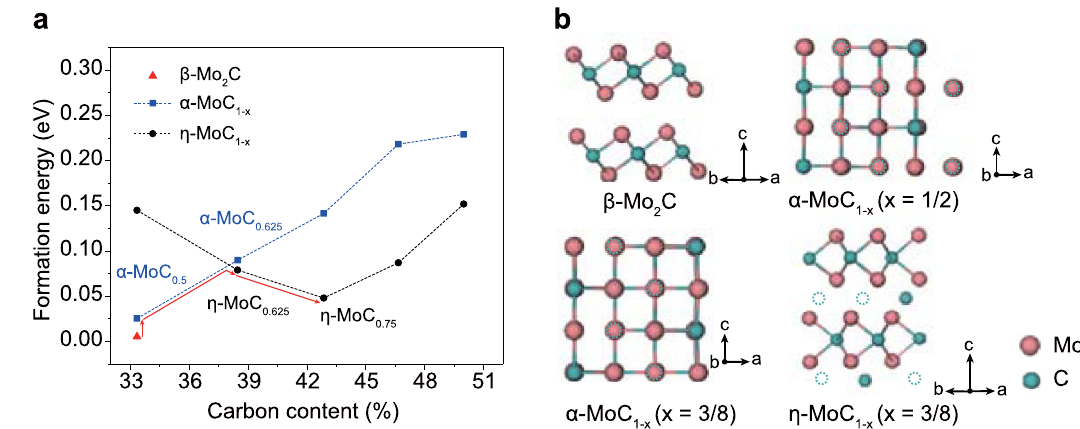
Fig. 3 Phase transformation process of molybdenum carbides revealed by density functional theory (DFT) calculations. a Formation energy of β -Mo 2 C, and α -MoC 1-x and η -MoC 1-x with different carbon atomic content. The red line denotes the projected phase transformation pathway. b Calculated crystal structures of β -Mo 2 C, α -MoC 1-x ( x = 1/2), α -MoC 1-x ( x = 3/8), and η -MoC 1-x ( x = 3/8). The dashed circles denote the carbon